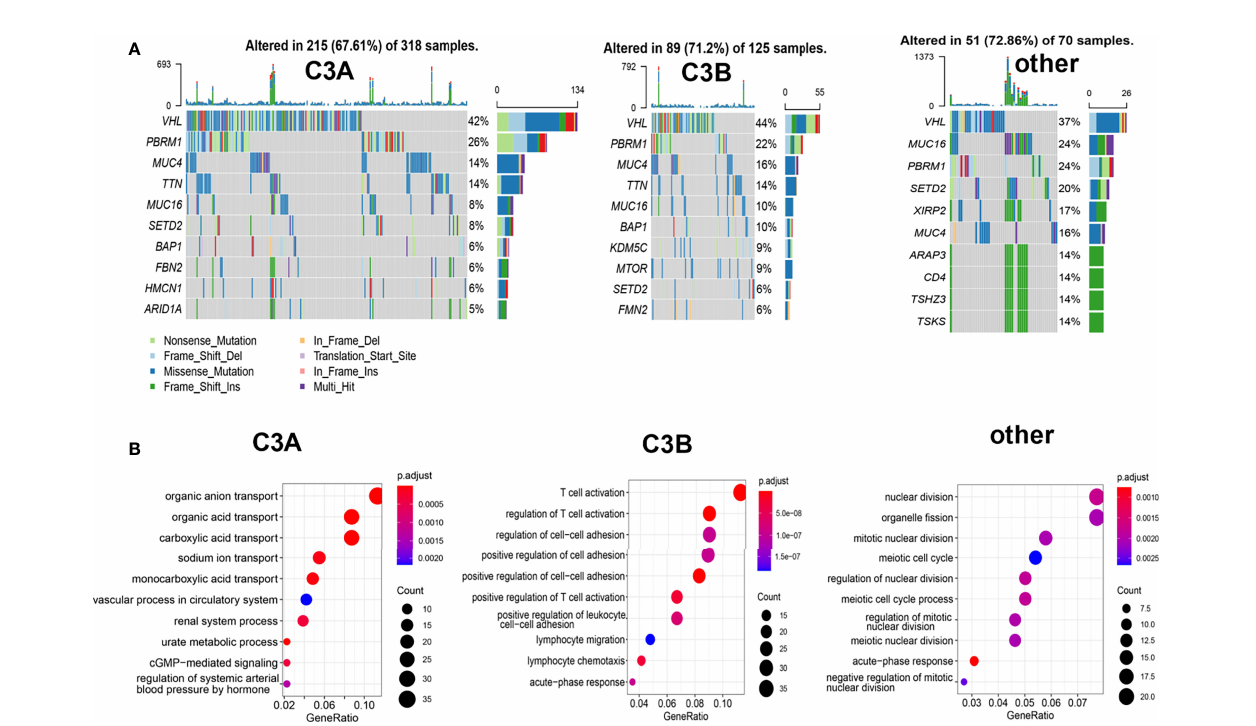
FIGURE 5 | Somatic mutation and enrichment analysis of ccRCC with different immune subtypes. (A) Oncoplots of ccRCC in different immune subtypes. (B) Potentially enrichment pathways based on the enriched genes in each immune subtype of ccRCC. ccRCC, clear cell renal cell